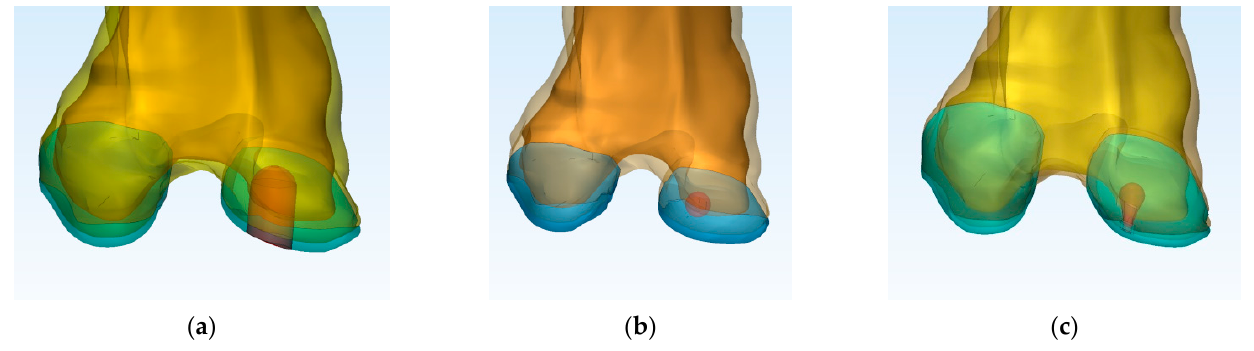
Figure 5. Location and the shape of UC after 7 months postoperatively: ( a ) Case 1 (just porous Collagen); ( b ) Case 2 (Collagen + BMC); ( c ) Case 3 (Collagen + ASC).